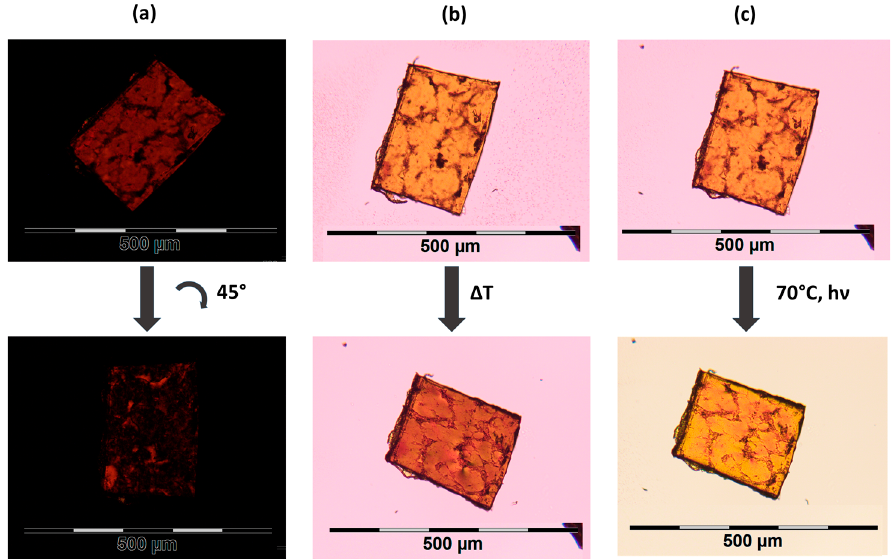
Figure 4. Polarized light microscope (POM) images of an LCE film with 10 mol % crosslinker, a thickness of 50 µm, and polymerized at 60 °C. ( a ) Cross-polarized light image at 70 °C with the film being rotated by 45° in the second image; ( b ) film in its glassy phase at RT and after heating it above the clearing temperature at 110 °C; ( c ) film at 70 °C before and after illumination with a white cold light source.